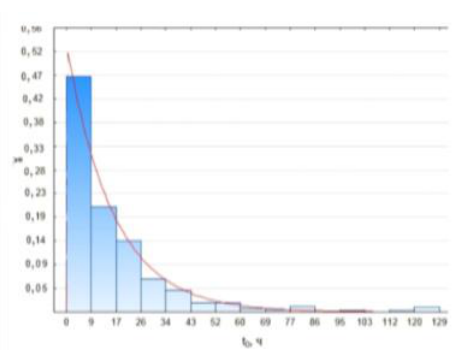
Figure 1. Histograms and distribution frequency functions of a time per fault of a mechanical part of rope